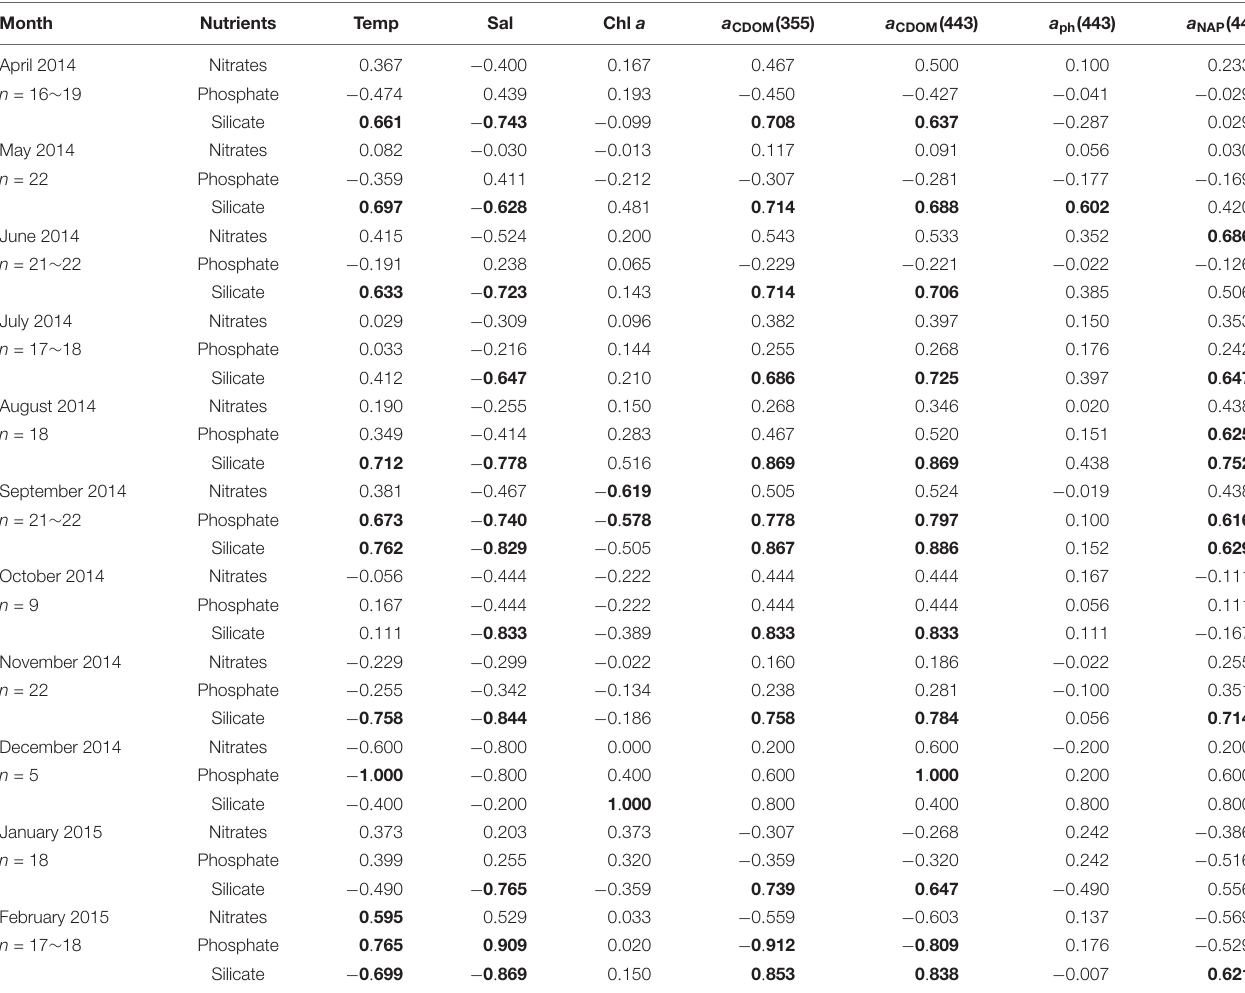
TABLE 4 | Kendall rank correlations coefficient ( τ ) between nutrient concentrations, environmental variables (temperature, salinity, Chl a concentration), and light absorption properties at the surface in AB during sampling cruises.